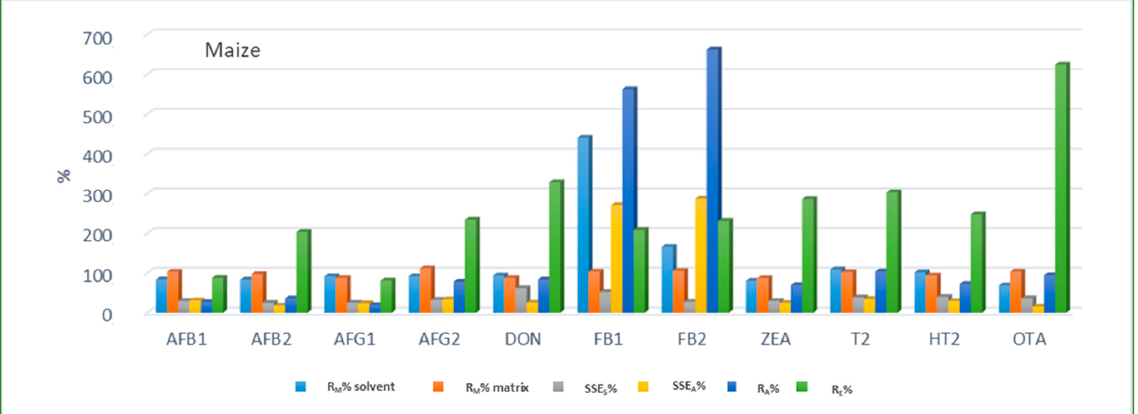
Figure 3. Method recovery (R M ), matrix effect (SSE S -slope, SSE A -area), apparent recovery (R A ) and extraction efficiency (R E ) in maize.